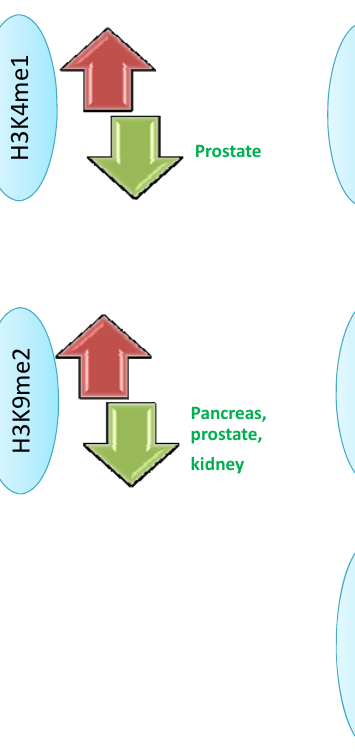
Figure 3. Pattern of methylation-demethylation associated with different types of